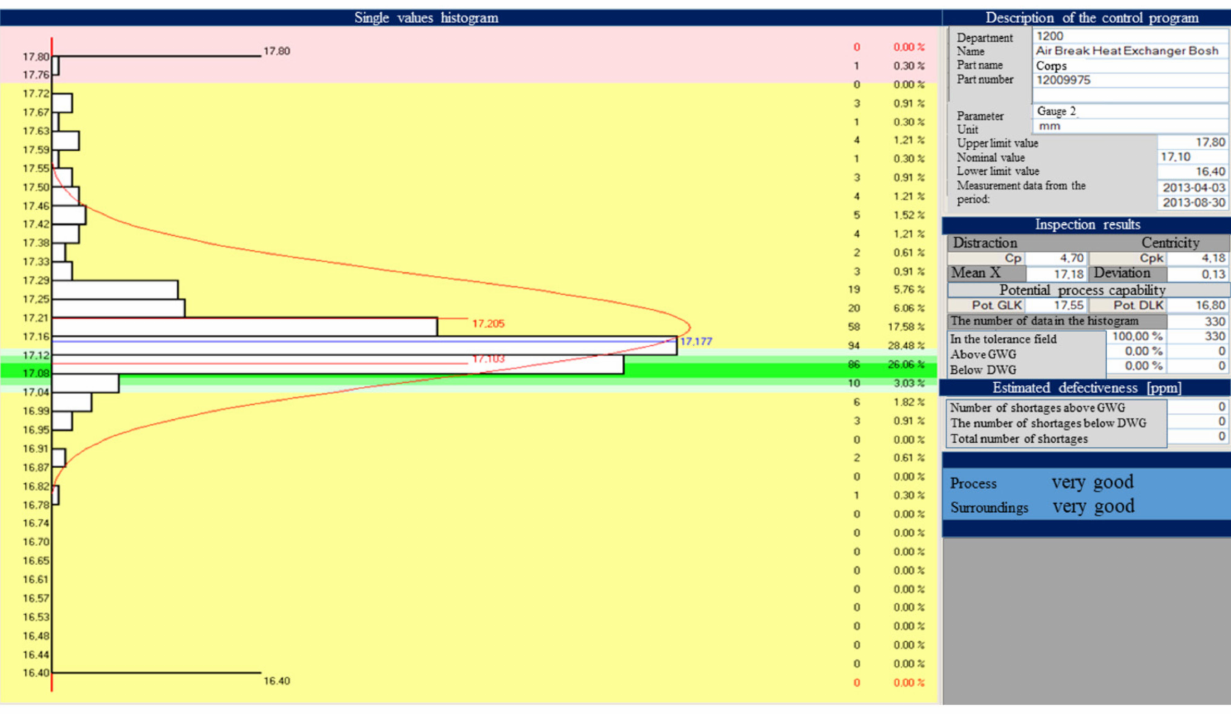
Figure 27. Histogram showing the consistent